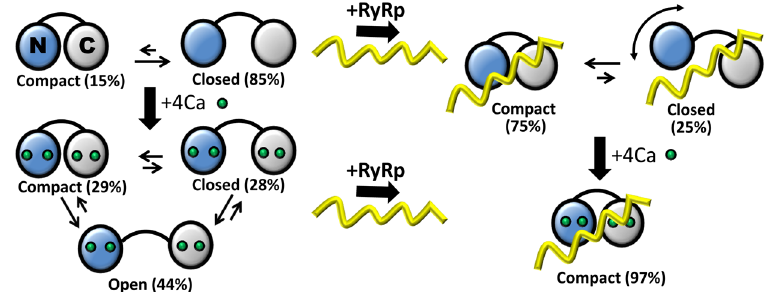
Figure 6. Schematic of structural models based on DEER distance measurements (Figs 3 and 4). Blue, N-lobe of CaM; gray, C-lobe of CaM; yellow, RyRp; green, Ca ion. In the absence of RyRp and Ca (upper left) CaM is primarily in the closed structural state. Ca binding to CaM (bottom left) populates all three states (open, closed, compact), with the open state predominant. In the presence of RyRp and the absence of Ca (upper right), the complex is in dynamic equilibrium between the compact state, and a closed-like state with the N-lobe potentially being highly mobile and not bound to RyRp. Ca binding to CaM (bottom right) shifts the complex almost completely to the compact state by increasing binding of the N-lobe to